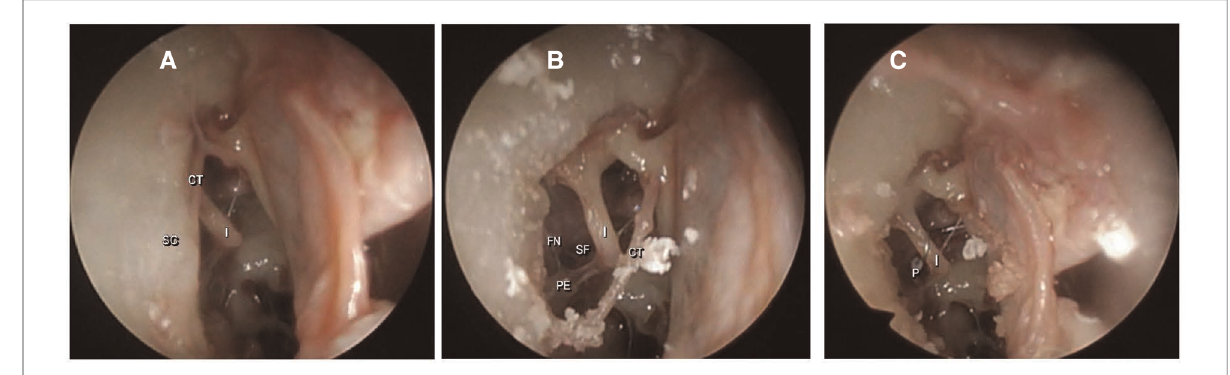
FIGURE 3 Endoscopic photographic view of the middle ear landmarks using a 4 mm endoscope with a 30° angle. ( A ) After dissection of the tympanomeatal fl ap; CT (chorda tympani), I (long process of the incus) and SC (scutum). ( B ) After scutum removal; PE (pyramidal eminence), FN (facial nerve) and SF (stapes footplate). ( C ) After prosthesis placement; P